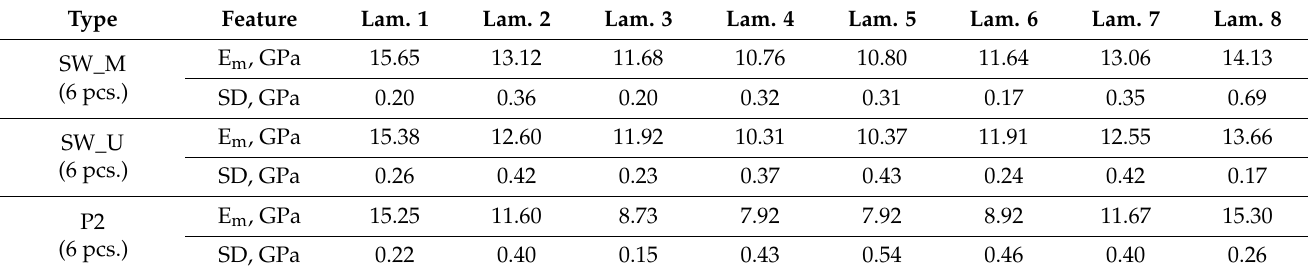
Table 1. Average moduli of elasticity of the lamellas used in the tests for 8-layer beams.